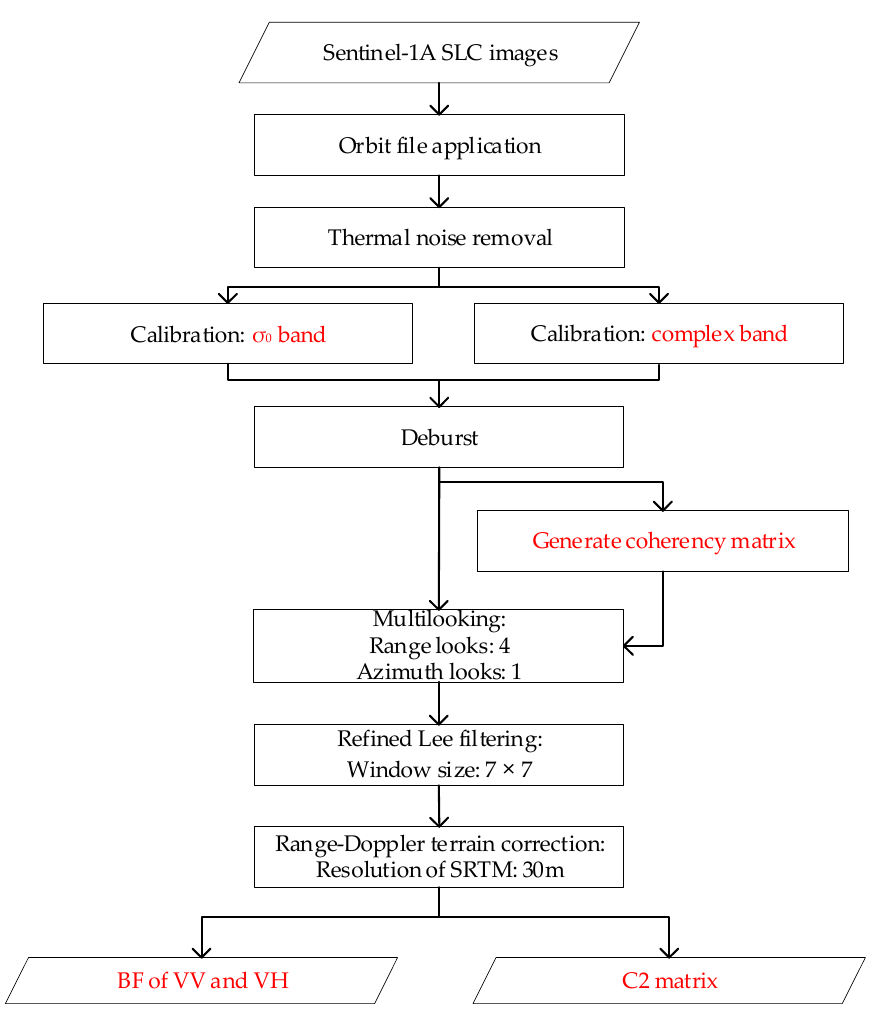
Figure 2. The pre-processing steps. Table 2. Ground truth samples in one scene SAR image in the study